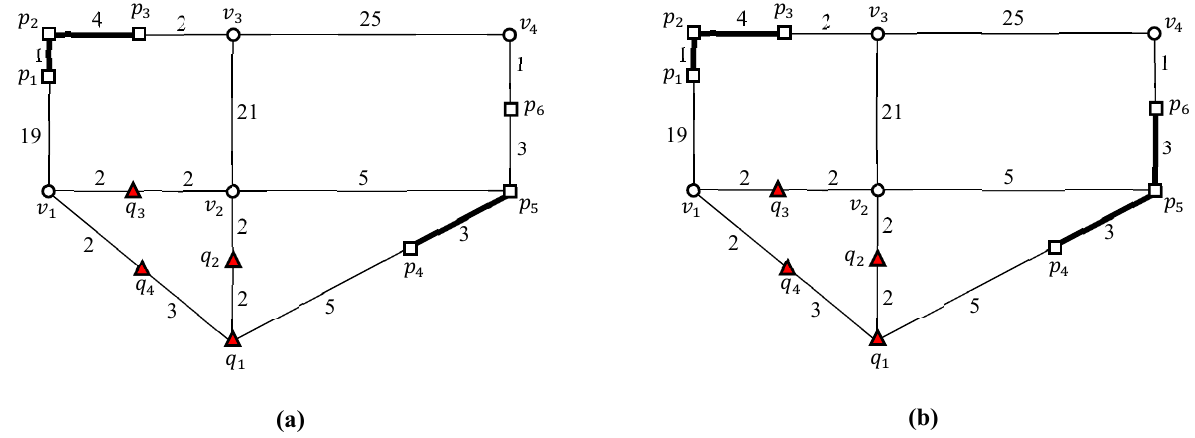
Figure 4. Two-step clustering method to group nearby data points into a data cluster: ( a ) converting data points into data segments; ( b ) converting data segments into data clusters.